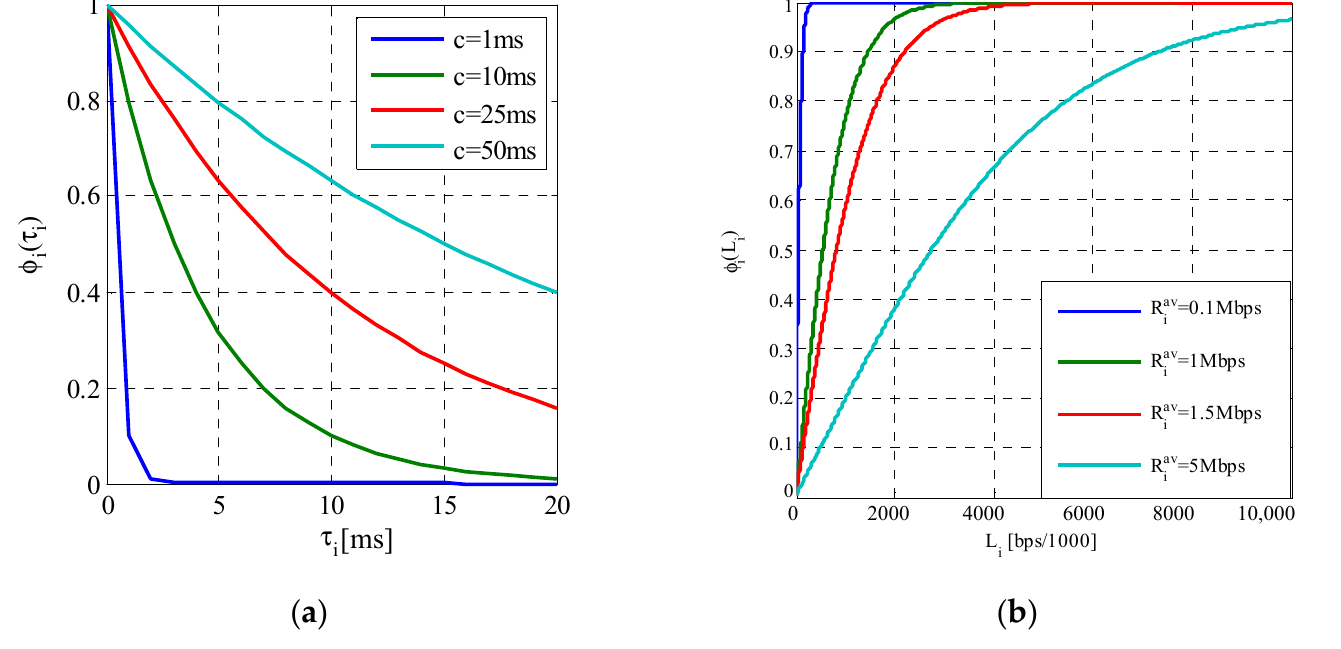
Figure 5. Potential functions for delay sensitive and best effort traffic types: ( a ) Variation of the potential function for delay sensitive traffic with latency τ i when coefficient c i has different values; ( b ) Variation of the potential function for best effort traffic with the instantaneous bit rate of the tunnel, L i , for different values of the expected average bit rate R av i .